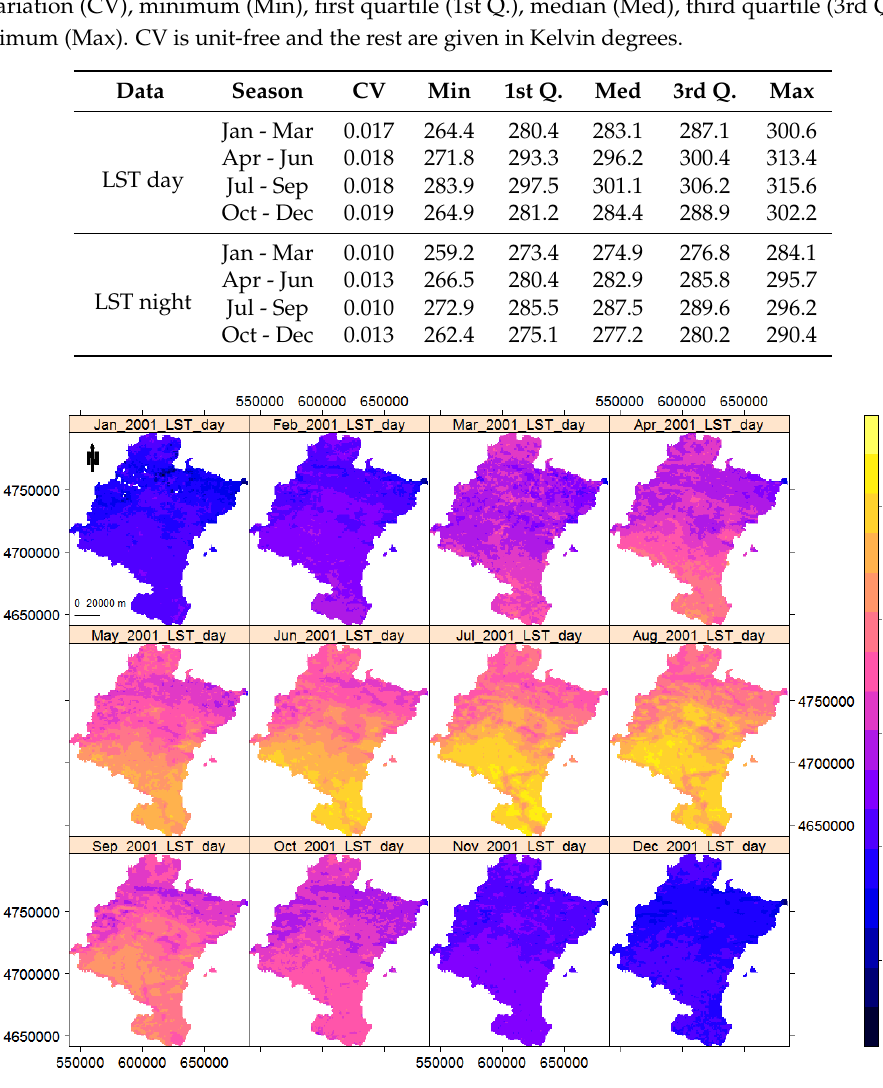
Figure 10. From the top-left to the bottom-right: monthly LST day (in Kelvin degrees) of Navarre, Spain, from January to December of 2001, in which the variation across the region and changes over months are